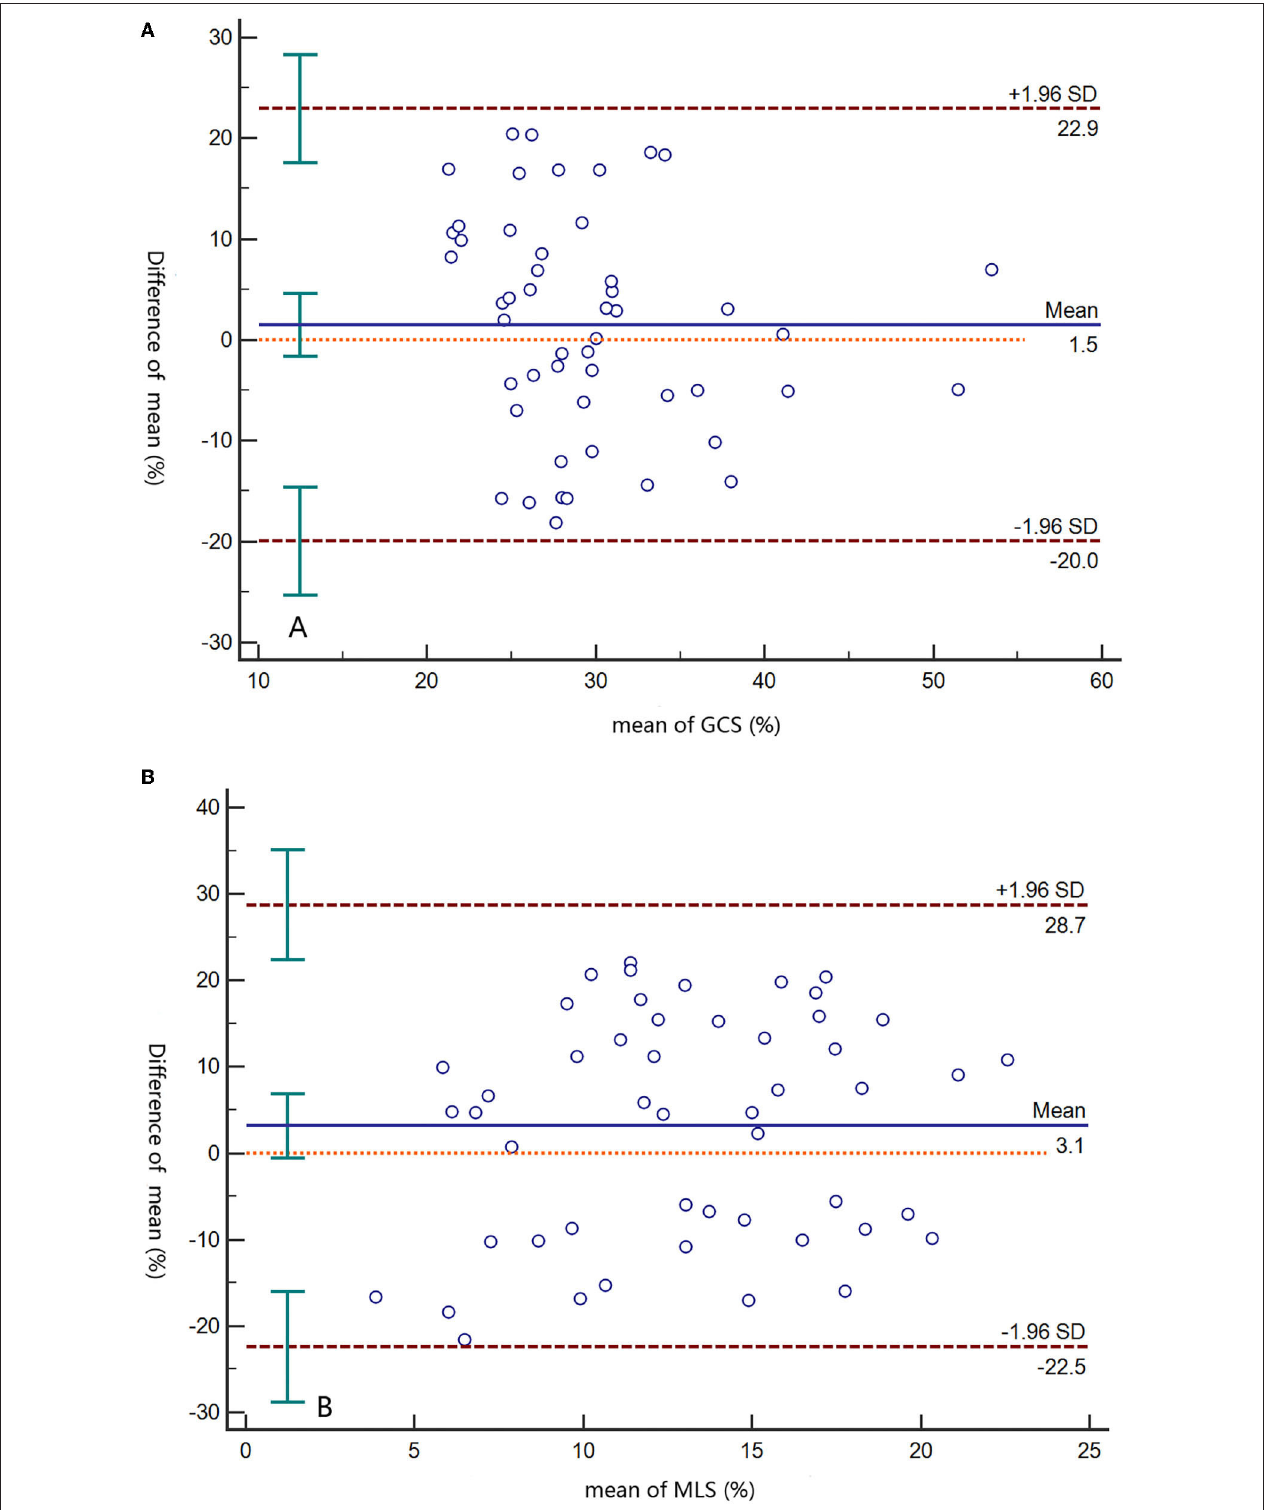
FIGURE 5 | Bland–Altman plots of interobserver differences at the GCS (A) and MLS (B) . Solid lines represent the means, and dashed lines indicate limits of agreement. GCS, global circumferential strain; MLS, mean longitudinal strain.